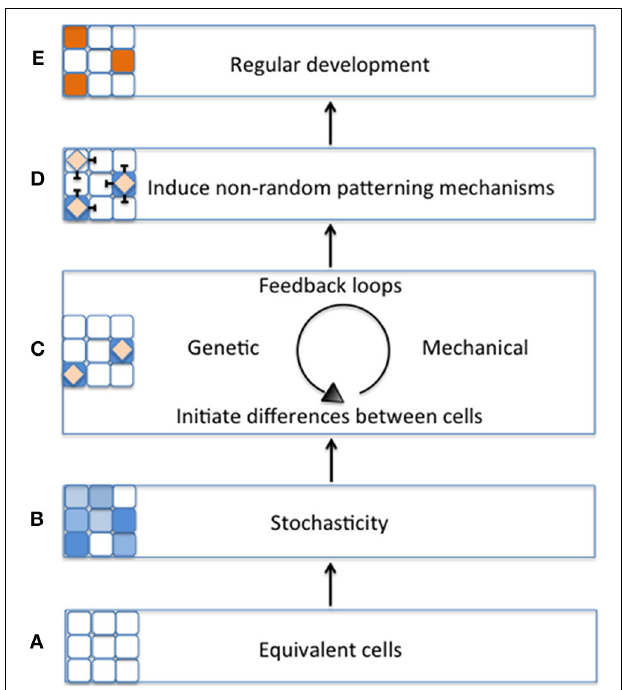
FIGURE 1 | Schematic model of the importance of stochasticity in promoting regular plant development. (A) During early tissue development, cell start out as being morphologically equivalent (all white cells). (B) Equivalent cells exhibit initial differences from one another through stochastic fluctuations in gene expression (variation of blue cells). (C) Differences between cells will be stabilized by regulatory mechanisms such as genetic or mechanical feedback loops (blue cells with diamonds). (D) As the cell’s fate is stabilized, it triggers non-random patterning mechanisms (e.g., lateral inhibition) (E) Patterning mechanisms promote regular tissue development (orange cells).